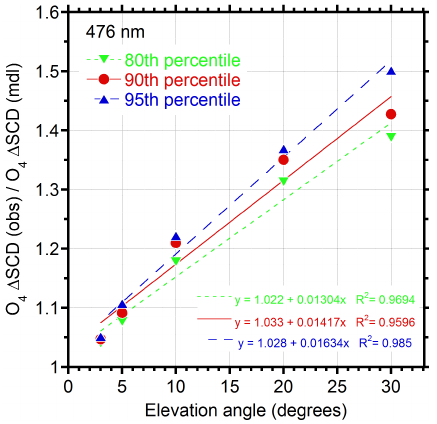
Figure 10. Relationships of 80, 90, and 95th percentiles of O 4 (cid:49) SCD (obs)/O 4 (cid:49) SCD (mdl) with α .